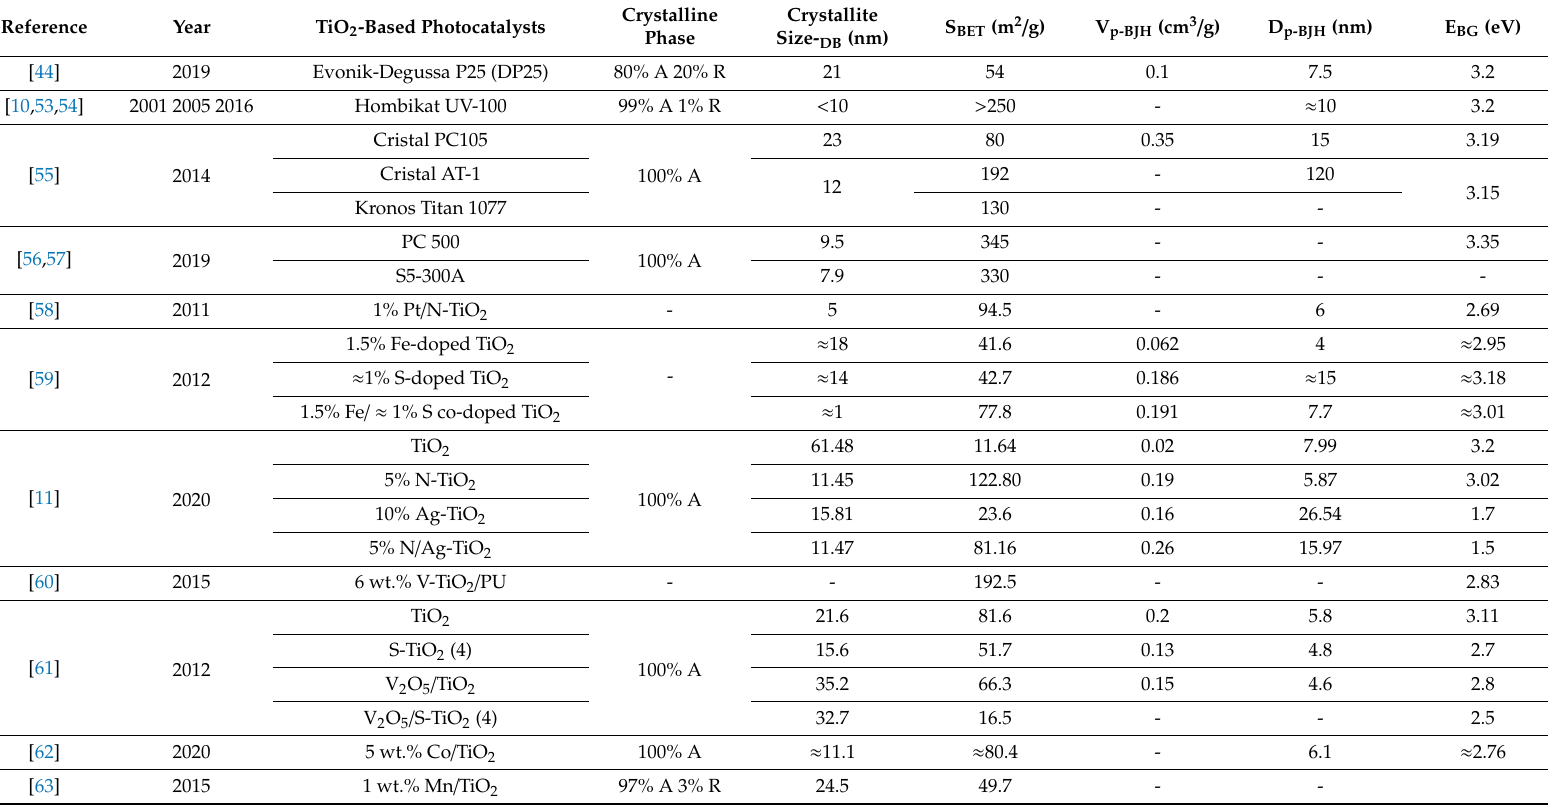
Table 1. Comparison of di ff erent commercial and synthesized TiO 2 -based photocatalysts for